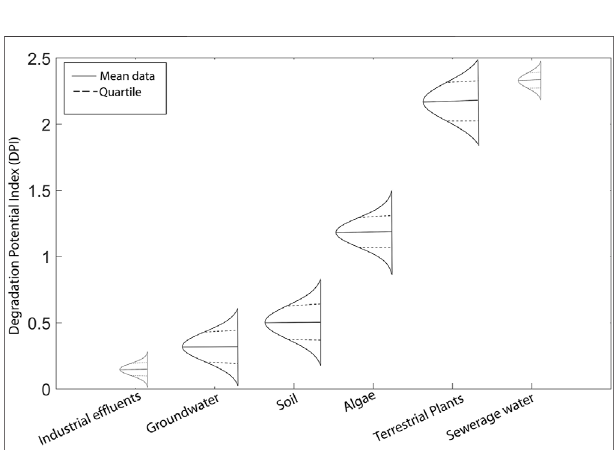
FIGURE 6 | Degradation potential index (DPI) of common natural and anthropogenic DOM sources in the environment. The DPI of sources was calculated using equation